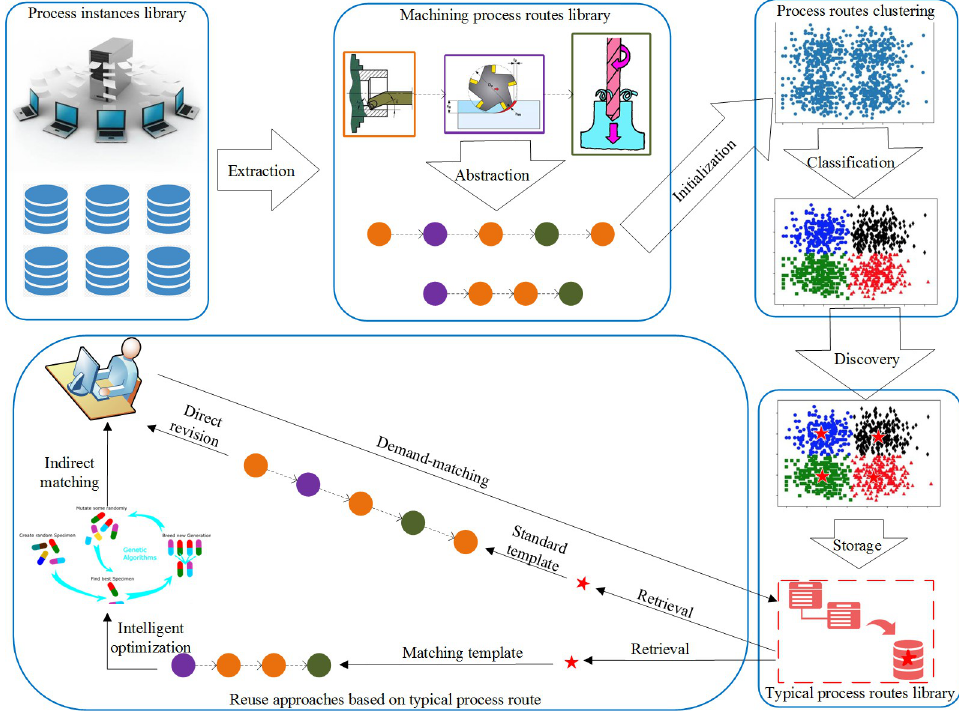
Fig 1. A framework for discovery and reuse of typical process